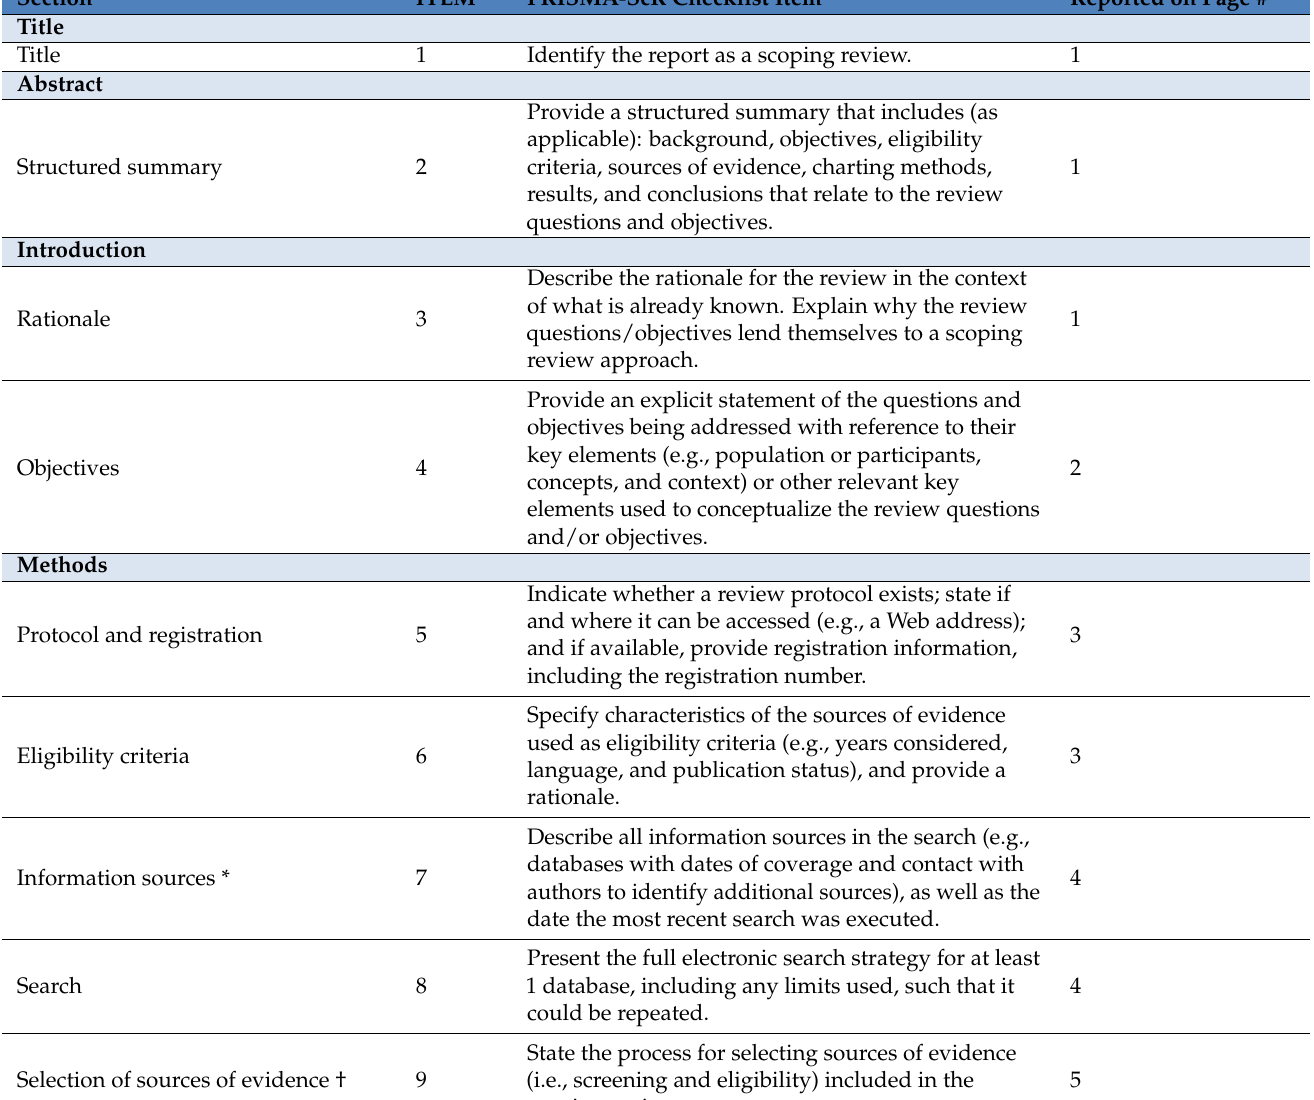
Table A1. Preferred Reporting Items for Systematic Reviews and Meta-Analyses extension for scoping reviews (PRISMA- ScR) checklist indicating the page on which the specific item is